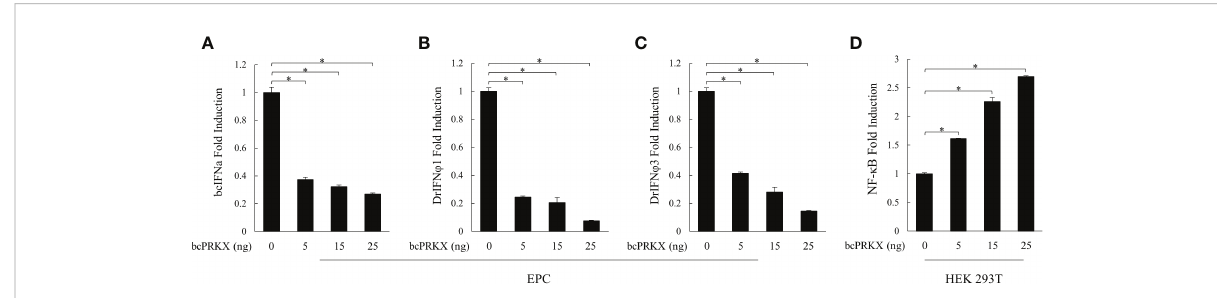
FIGURE 5 bcPRKX functioned in IFN and NF- k B signaling. (A-C) EPC cells were co-transfected with bcPRKX, Luci-bcIFNa or Luci-DrIFN f 1/3 and pRL-TK separately. (D) HEK 293T cells were co-transfected with bcPRKX, Luci-NF- k B and pRL-TK. The cells were harvested for luciferase reporter assay at 24 h post-transfection according to the methods. Asterisk (*) stands for statistical difference